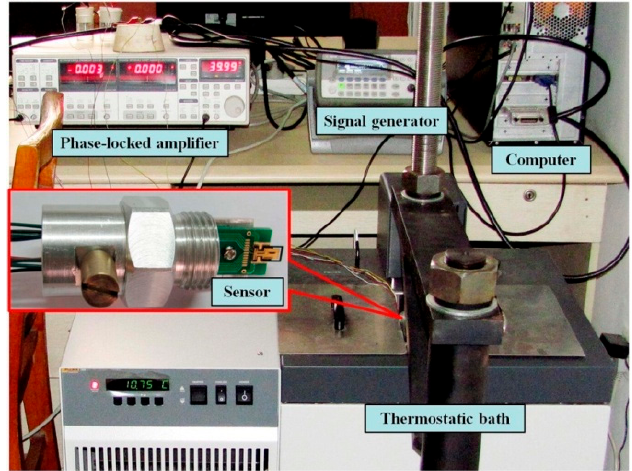
Figure 8. Experimental system.